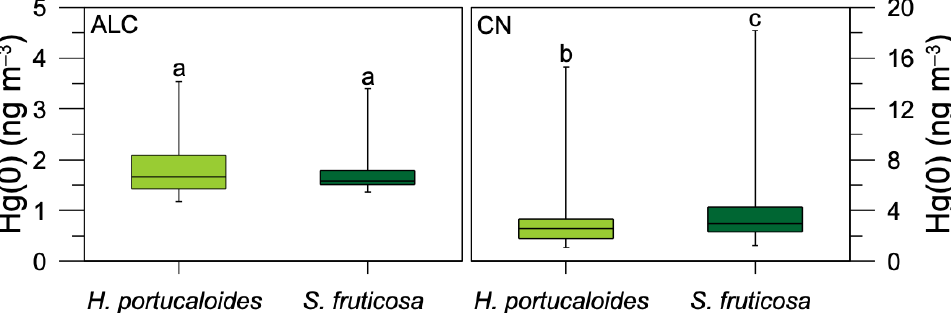
Figure 3. Air Hg(0) concentrations (ng m −3 ) in saltmarsh areas vegetated by Halimione portulacoides and Sarcocornia fruticosa in the background site ALC and industrial site CN. Significant differences among groups observed (Mann–Whitney test; p < 0.05) are indicated with different letters.